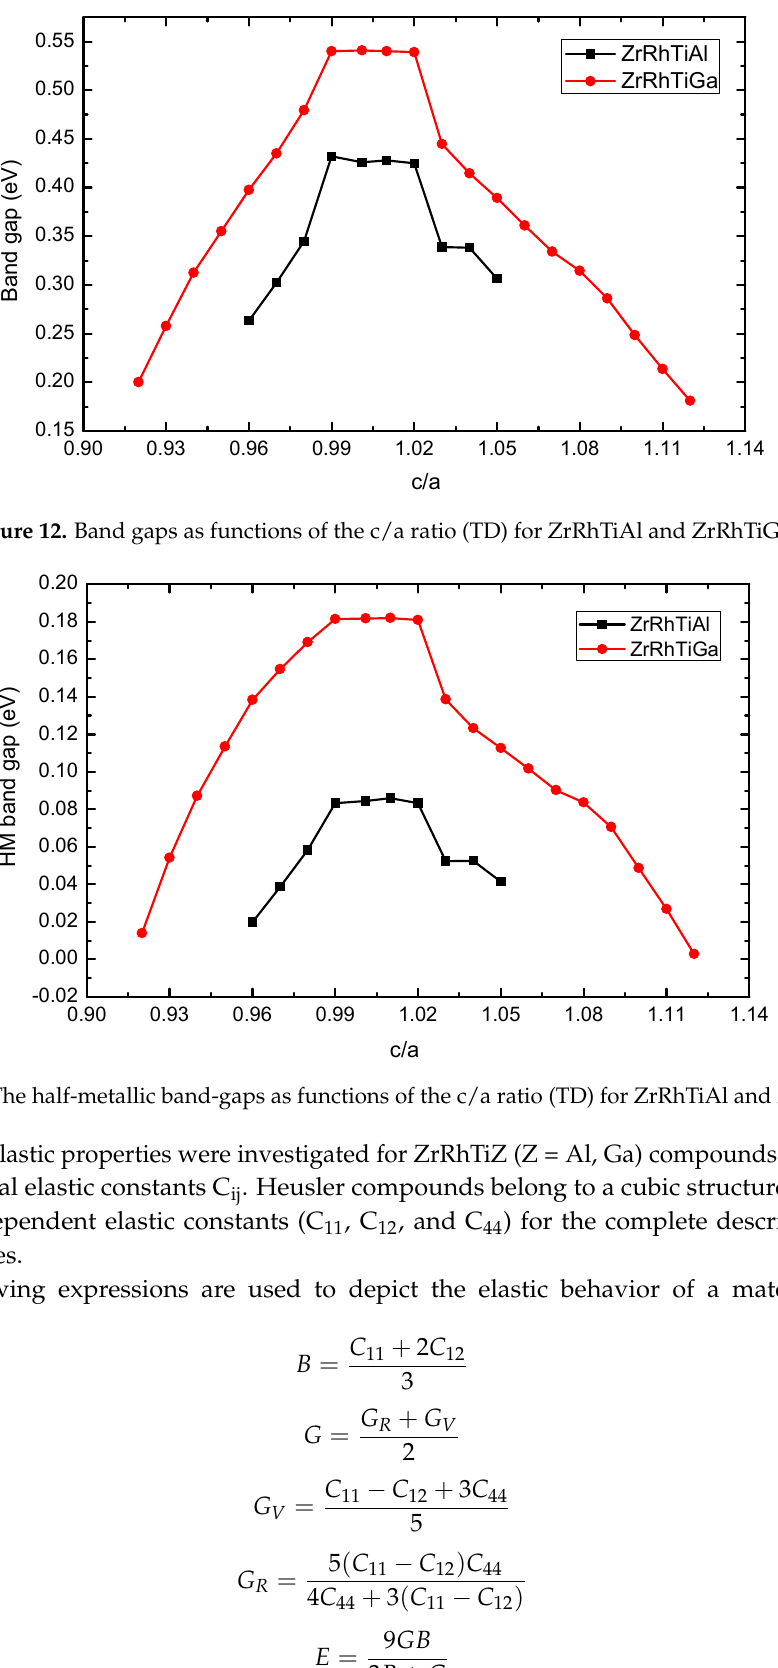
Figure 11. CBM and VBM in the minority channel as a function of c/a ratio (TD) for ZrRhTiAl ( a ) and ZrRhTiGa ( b ).